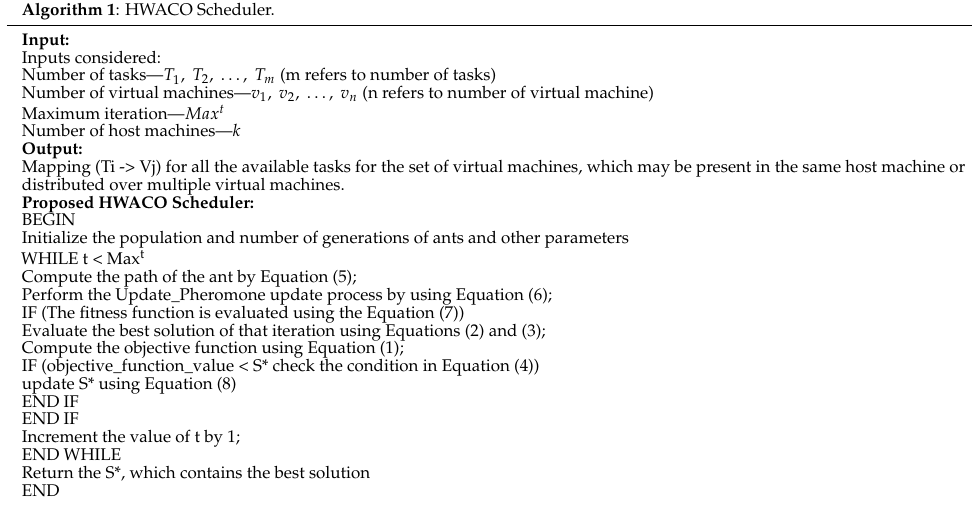
Algorithm 1 : HWACO